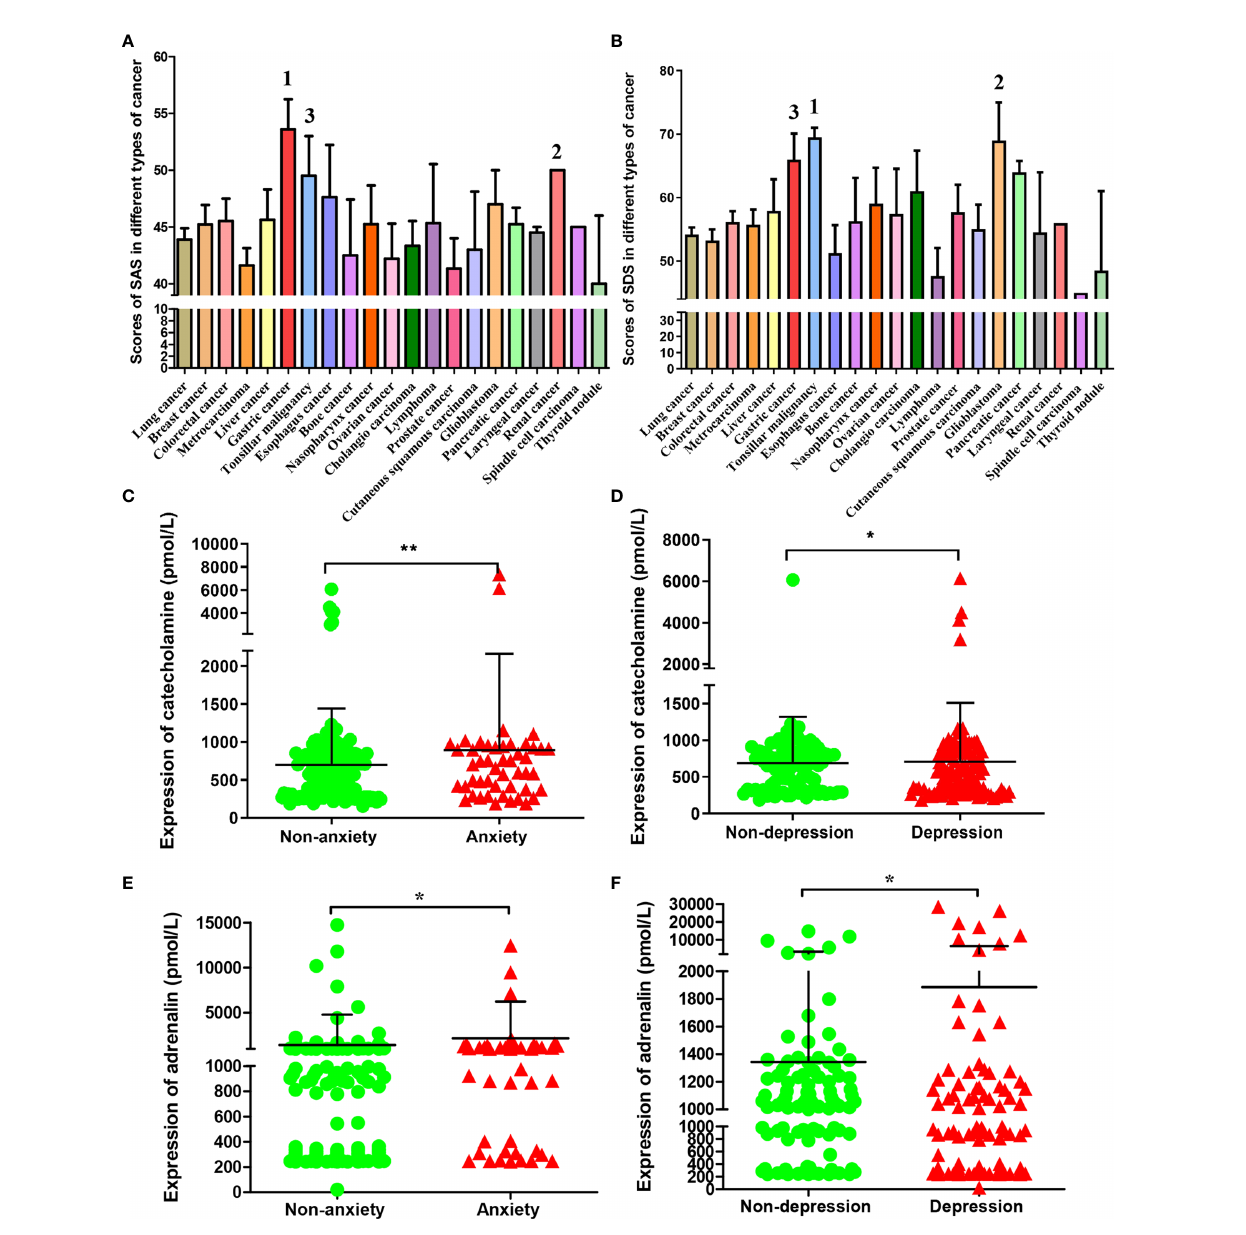
FIGURE 1 | SAS, SDS and chronic stress-related hormones levels in patients with different types of cancer. The average score of SAS (A) and SDS (B) in patients with different types of cancer. The cancer types of the top three in patients with SAS and SDS scores were marked respectively. The catecholamine (C) and adrenaline (E) concentrations in blood of cases who had or had no anxiety; The catecholamine (D) and adrenaline (F) concentrations in blood of cases who had or had no depression. Data represent mean ± SD (No anxiety group, n = 171, Anxiety group, n = 48; No depression group, n = 93; Depression group, n = 113; *P < 0.05, **P <